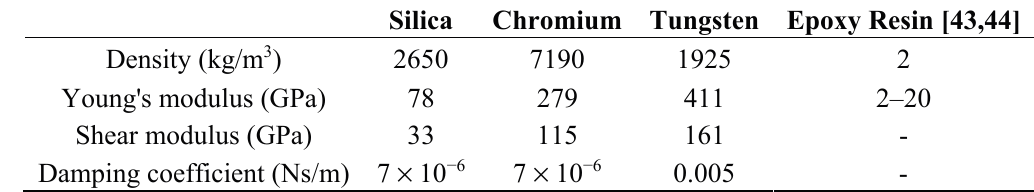
Table 2. Material parameters of a tungsten probe glued to a TF prong with epoxy